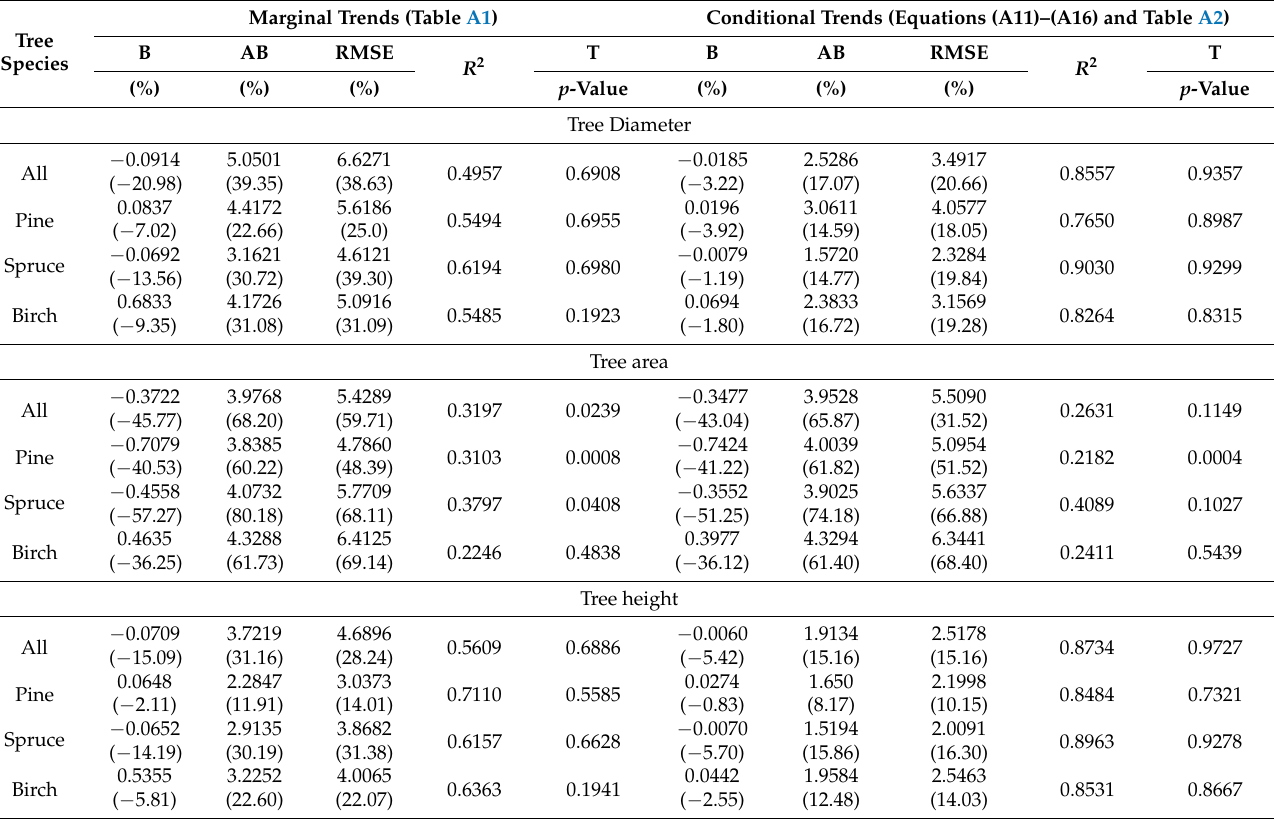
Table 3. Statistical measures and p -values of the Student’s t -test for the predictions of the individual- tree scenario